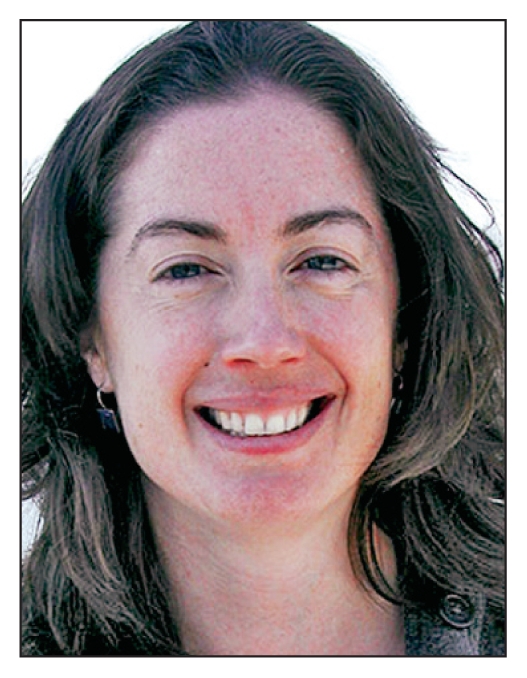
Jane Clougherty